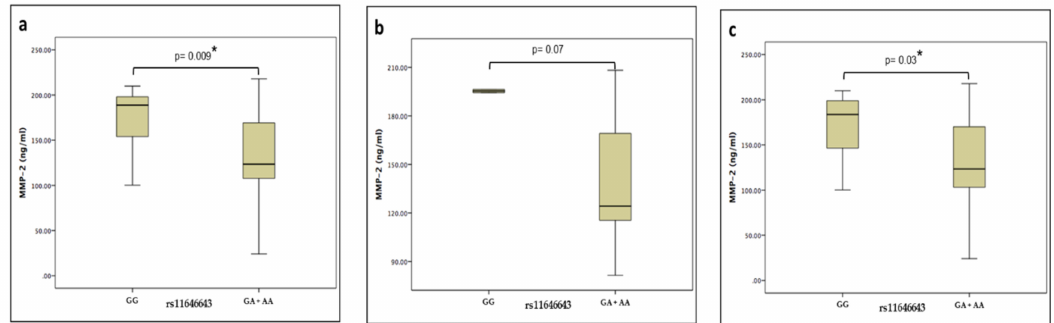
Figure 1. Median values and interquartile ranges of MMP-2 plasma levels in ( a ) genotypes of hypersensitivity pneumonitis ( b ) phenotype with positive autoantibodies ( c ) phenotype negative to